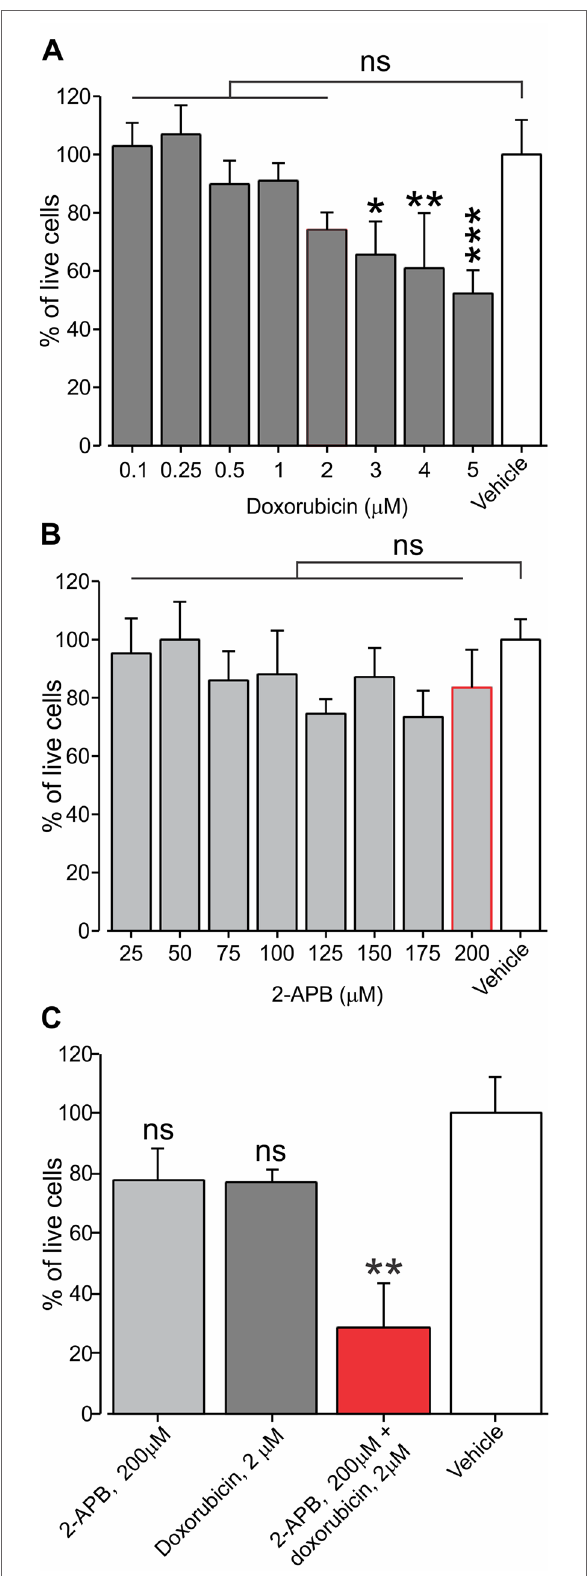
FIGURE 5 | Application of sub-effective dose of doxorubicin together with 2-APB leads to a decrease in living BNL1 ME cells. (A) Live-cell fluorescence measurements from cultured BNL1 ME cells 24 h after treatment with doxorubicin alone at the indicated doses. Note that only treatment with doses higher than 2 µM leads to a significant reduction in the number of live cells (measured as a relative level of fluorescence; see Methods ). (B) Same as in A but cells were treated for 24 h with 2-APB at the indicated dosed. Note that 2-APB does not affect cell viability at all examined doses. (C) Live- cell fluorescence measurements from cultured BNL1 ME cells show 24-h treatment with previously ineffective 2 µM doxorubicin applied together with 200 µM 2-APB leads to a significant decrease tumor cells viability, *p < 0.05, **p < 0.01, ***p < 0.001, ns, not significant; one-way ANOVA, comparison between the vehicles to all other groups, n = 6 wells for each group, three